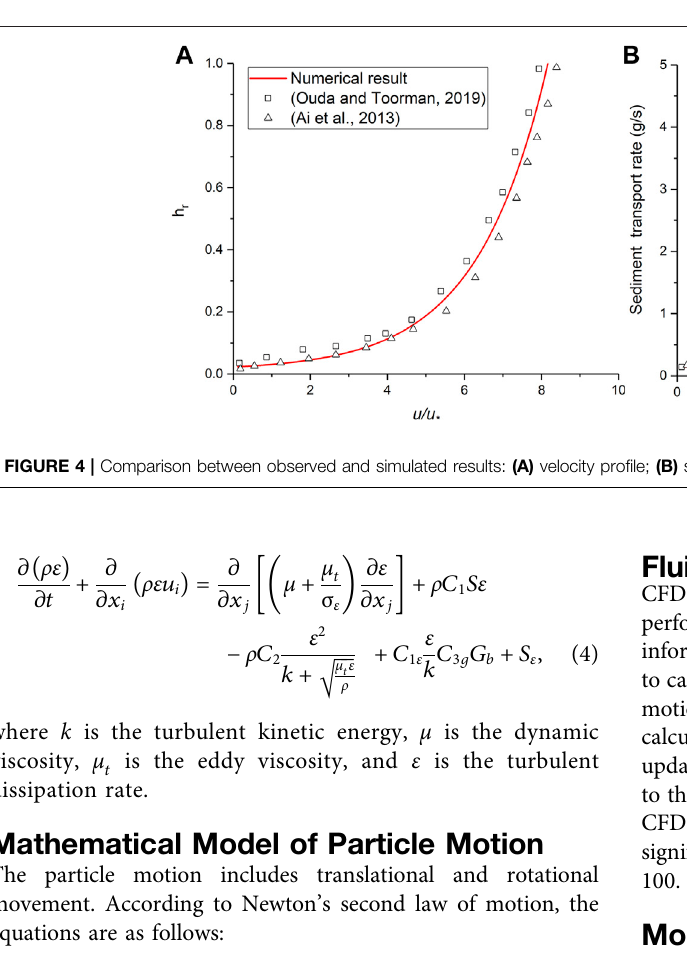
Frontiers in Earth Science |